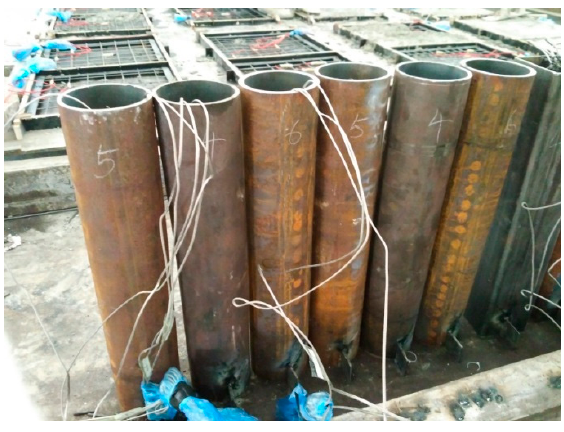
Figure 6. Construction of the specimens.